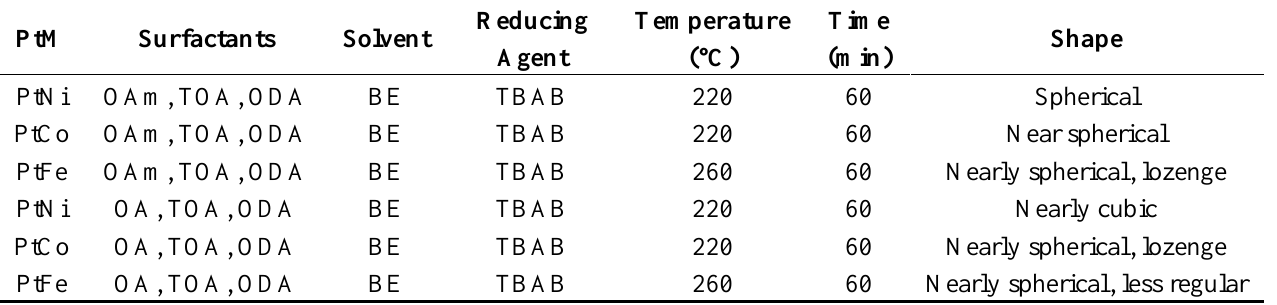
Table 1. Reaction parameters for the synthesis of highly monodispersed PtM alloy nanoparticles in the in the solvent BE.